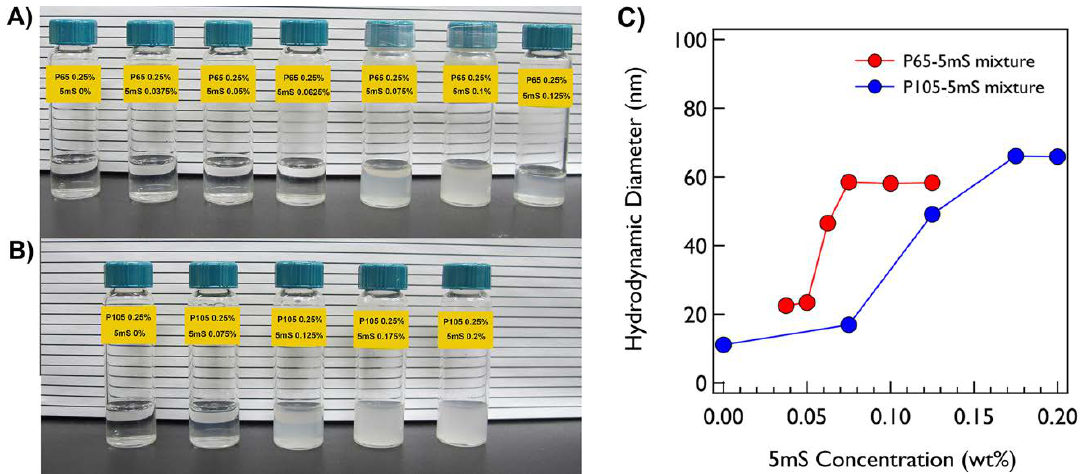
Figure 1. ( A ) Photos of P65-5mS mixtures at 25 °C. ( B ) Photos of P105-5mS mixtures 25 °C. ( C ) Hydrodynamic Diameters of P65-5mS and P105-5mS mixtures at 25 °C.